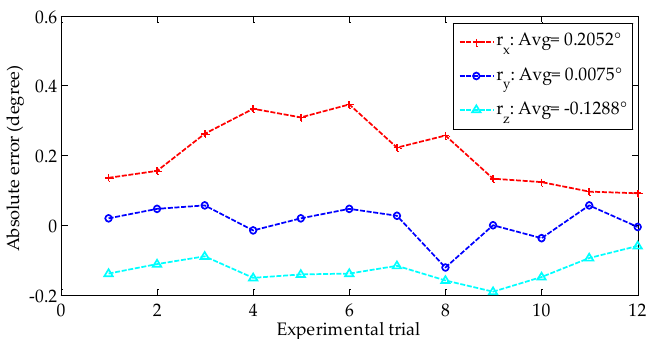
Figure 10. Absolute error of the three Euler angles.